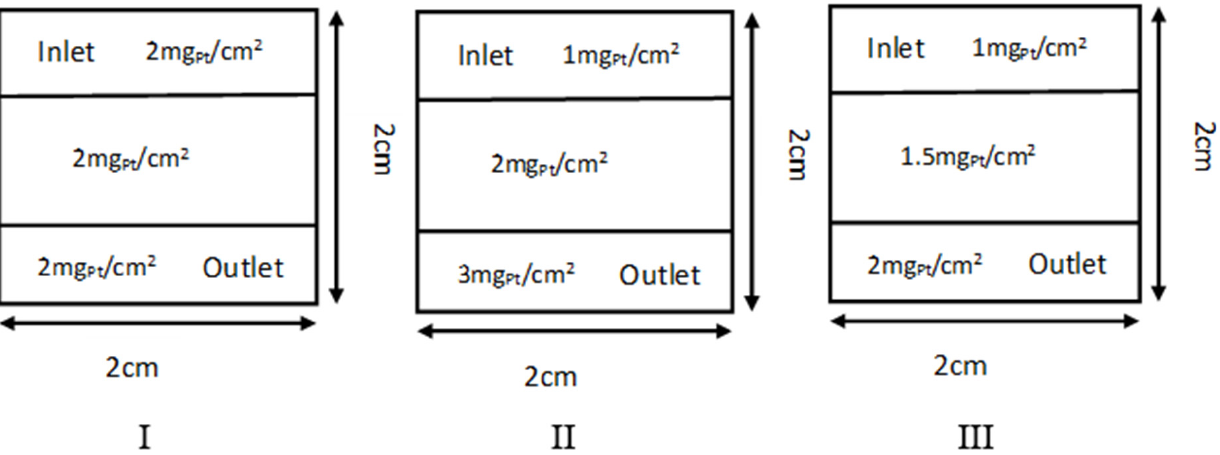
Figure 1. Catalyst loading types in both cathode and anode. I is a uniform electrode with an average Pt loading of 2 mg cm − 2 , II is a gradient electrode with an average Pt loading of 2 mg cm − 2 , III is a gradient electrode with an average Pt loading of 1.5 mg cm − 2 .